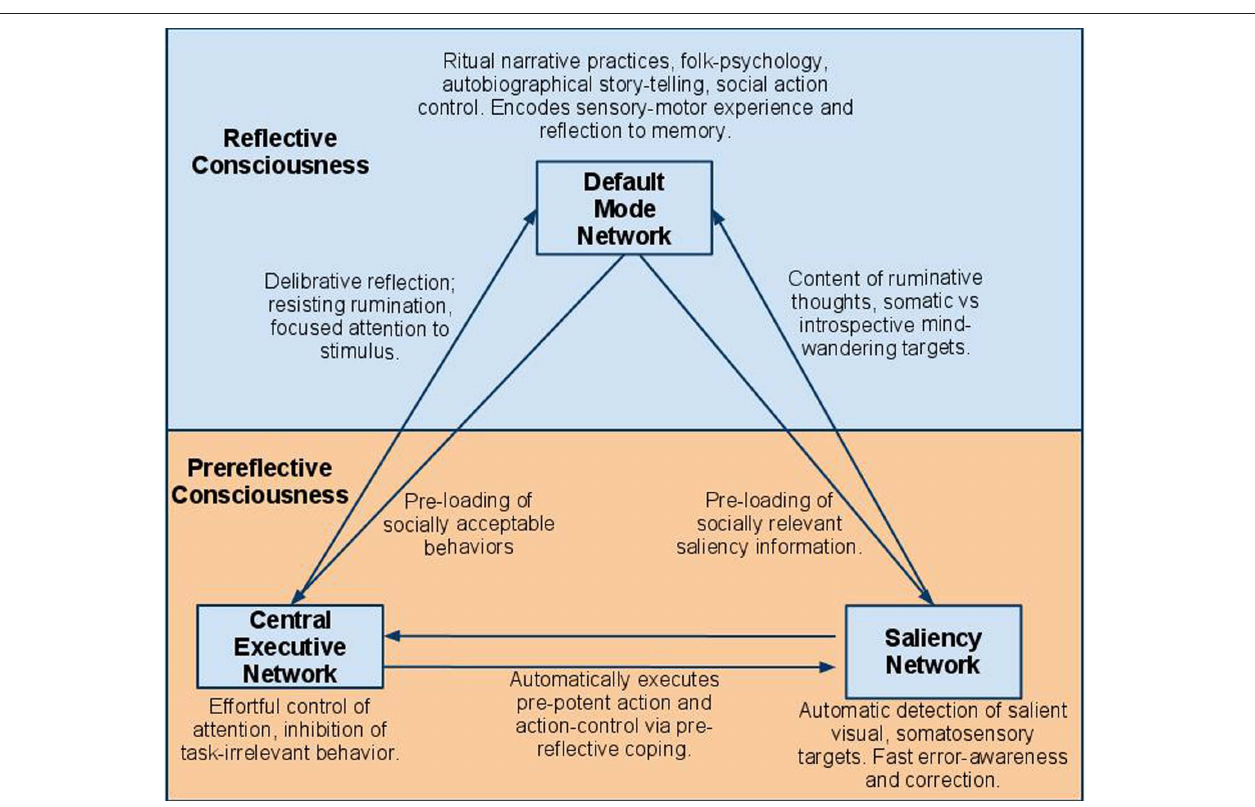
FIGuRe 1 | Diagram of resting-state network mappings to prereflective and reflective consciousness. Arrows represent interactions between networks. DMN includes medial-prefrontal cortex, the posterior cingulate cortex, the inferior parietal lobule, the lateral and inferior temporal cortex, and the medial